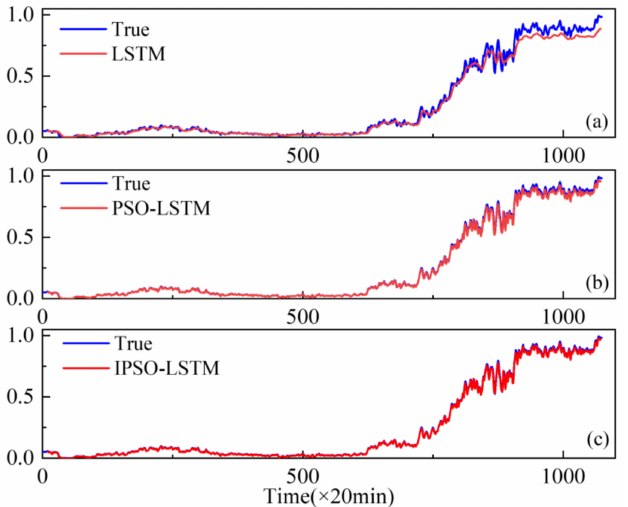
Figure 7. Performance degradation predictions of roller bearings for the: ( a ) LSTM; ( b ) PSO-LSTM; ( c )